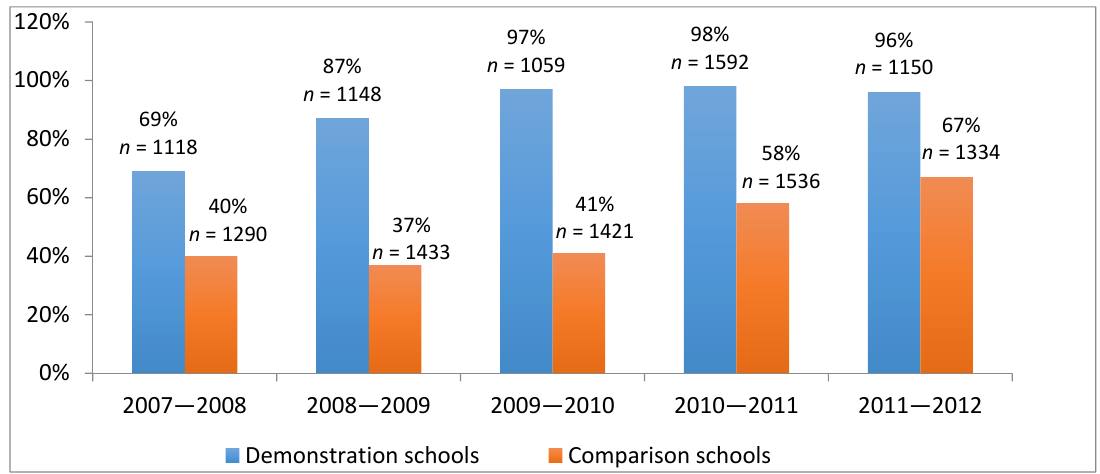
Figure 1. Percentage of students with vision problems examined by vision specialist after nurse referral ( n = Actual number of students who were screened for vision that year).